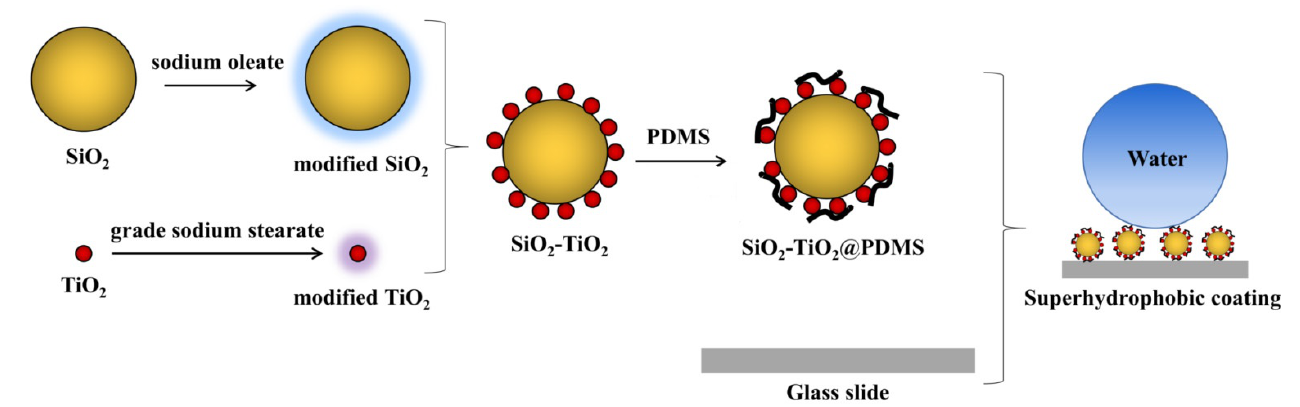
Figure 1. Preparation flowchart of superhydrophobic A-SiO 2 /N-TiO 2 @PDMS coating.